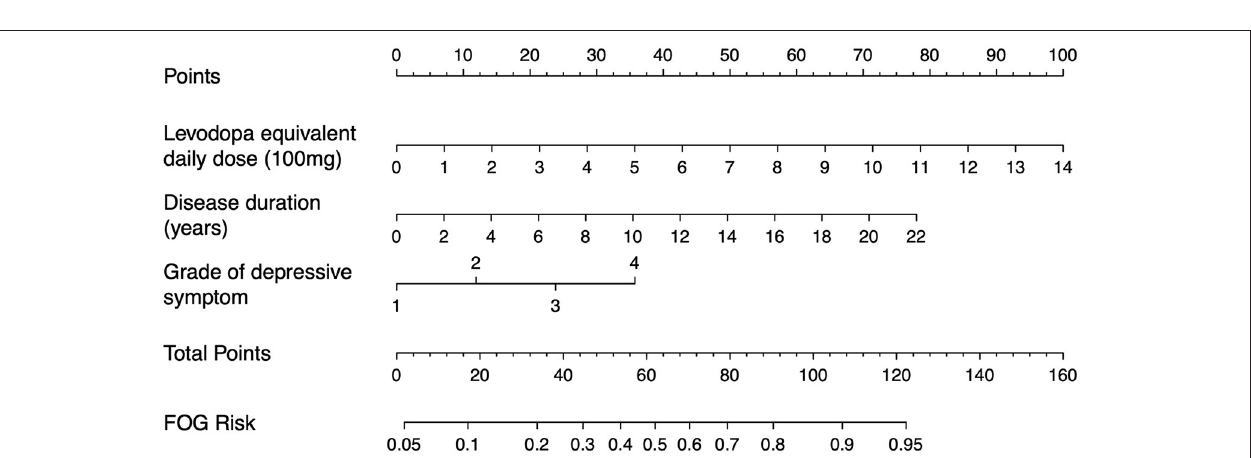
FIGURE 3 | Receiver operating characteristic (ROC) curve at 5-fold cross-validation. The gray reference line corresponds to a C-statistic of 0.50, indicating a non-informative model. The area under the curve of each ROC curve is shown at the lower right corner.